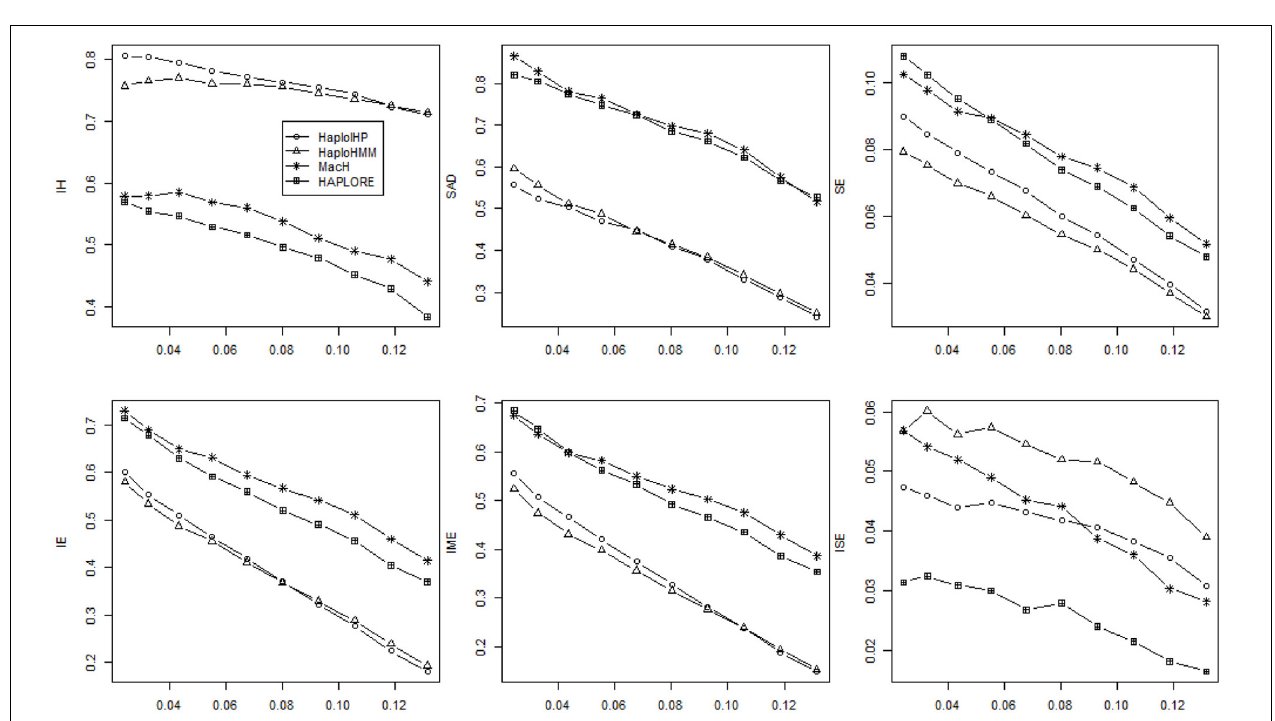
represents the standard deviation of haplotype frequencies used in simulations. Results were obtained when no incorrect haplotypes were included as identified haplotypes.